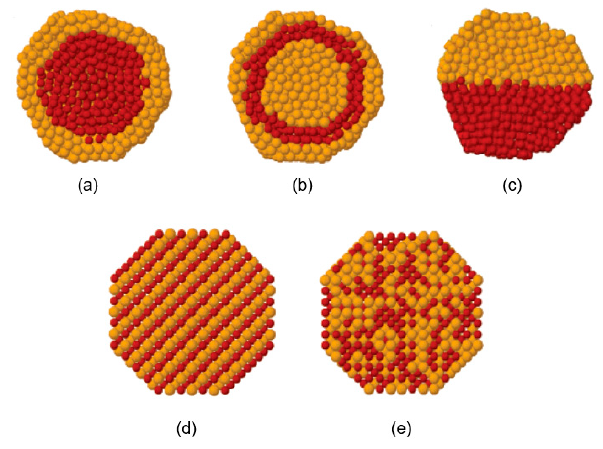
Figure 9. Microstructures of bimetallic NPs. ( a ) core-shell structure; ( b ) multi-shell structure; ( c ) biphase structure; ( d ) intermetallic structure; ( e ) nanoalloy. Reproduced with permission from Reference [249]. Copyright 2008, American Chemical Society.